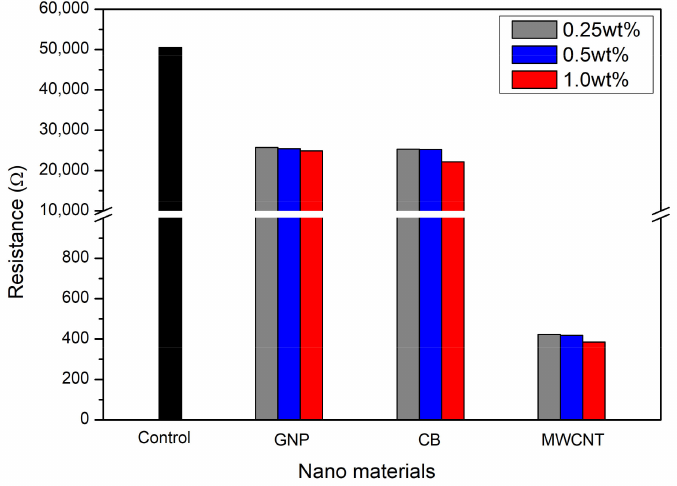
Figure 9. Resistance of the nanocementitious